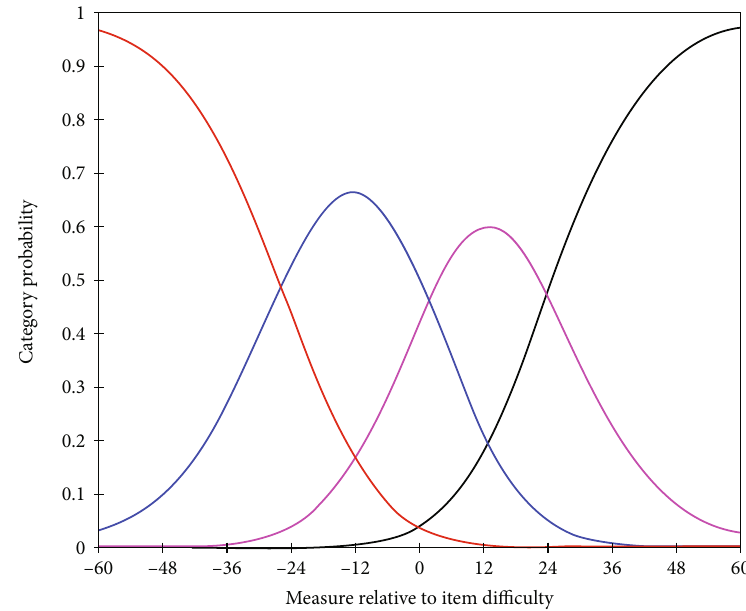
Figure 1: Rating scale validity. Table 4: Item and person summary statistics.